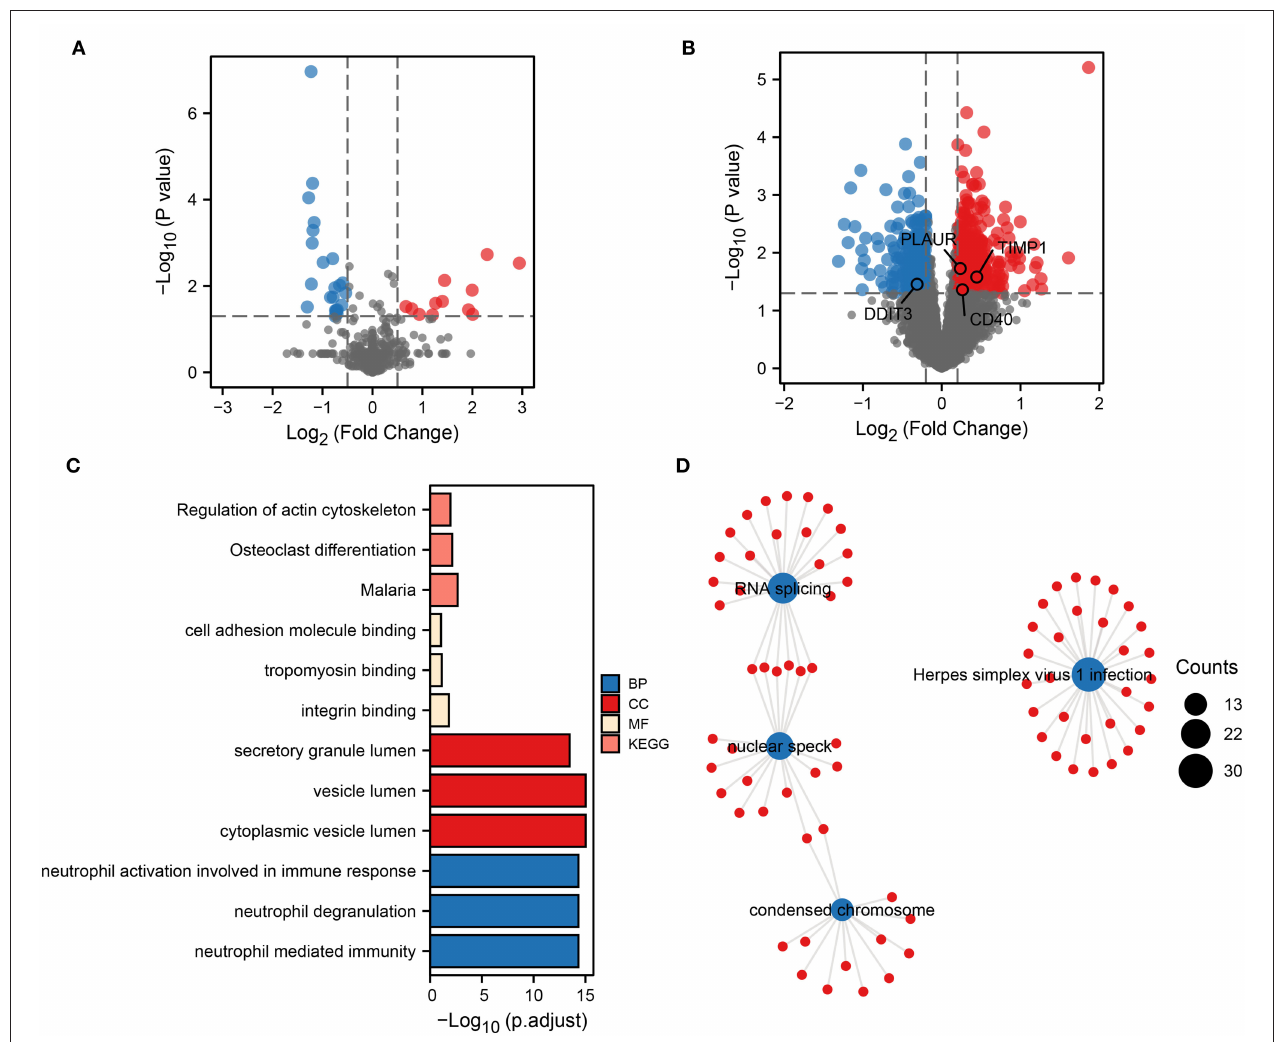
FIGURE 1 | Biological functional pathways of DEGs. Volcano plot showing DEmiRNAs (A) and DEmRNAs (B) . Red represents upregulated genes, and blue represents downregulated genes. Upregulated (C) and downregulated (D) biological functional pathways enriched by